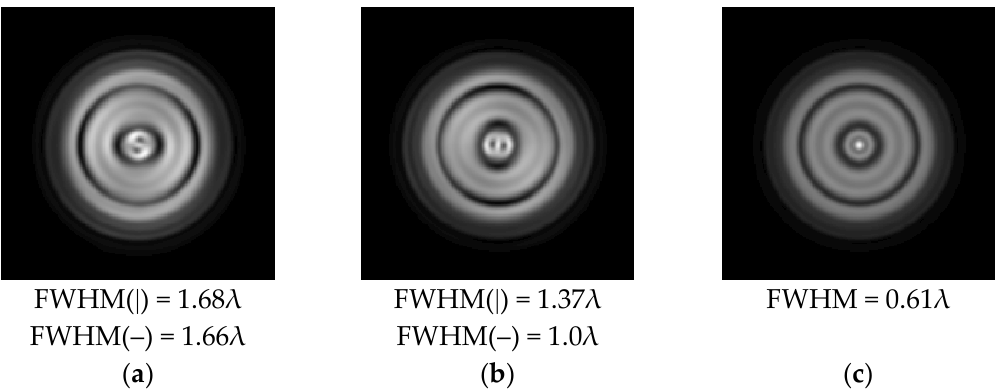
Figure 4. The diffraction of Laguerre–Gauss mode (0,1) with homogeneous polarization by a diffractive axicon with NA = 0.25, z 1 = 0.2λ, polarization: ( a ) x-linear, ( b ) y-linear, ( c ) “−” circular. For a diffractive axicon with NA = 0.95, recognition was possible up to z 1 = 3λ. Con- sider the cross-sections in terms of maximum intensity (more than 0.5λ) on the optical axis (Figure 5). It should be noted that for radial polarization, the size of the central focal spot did not change; for “−” circular, the size of the focal spot was comparable, and for linear polarization, a wider focal spot was obtained.